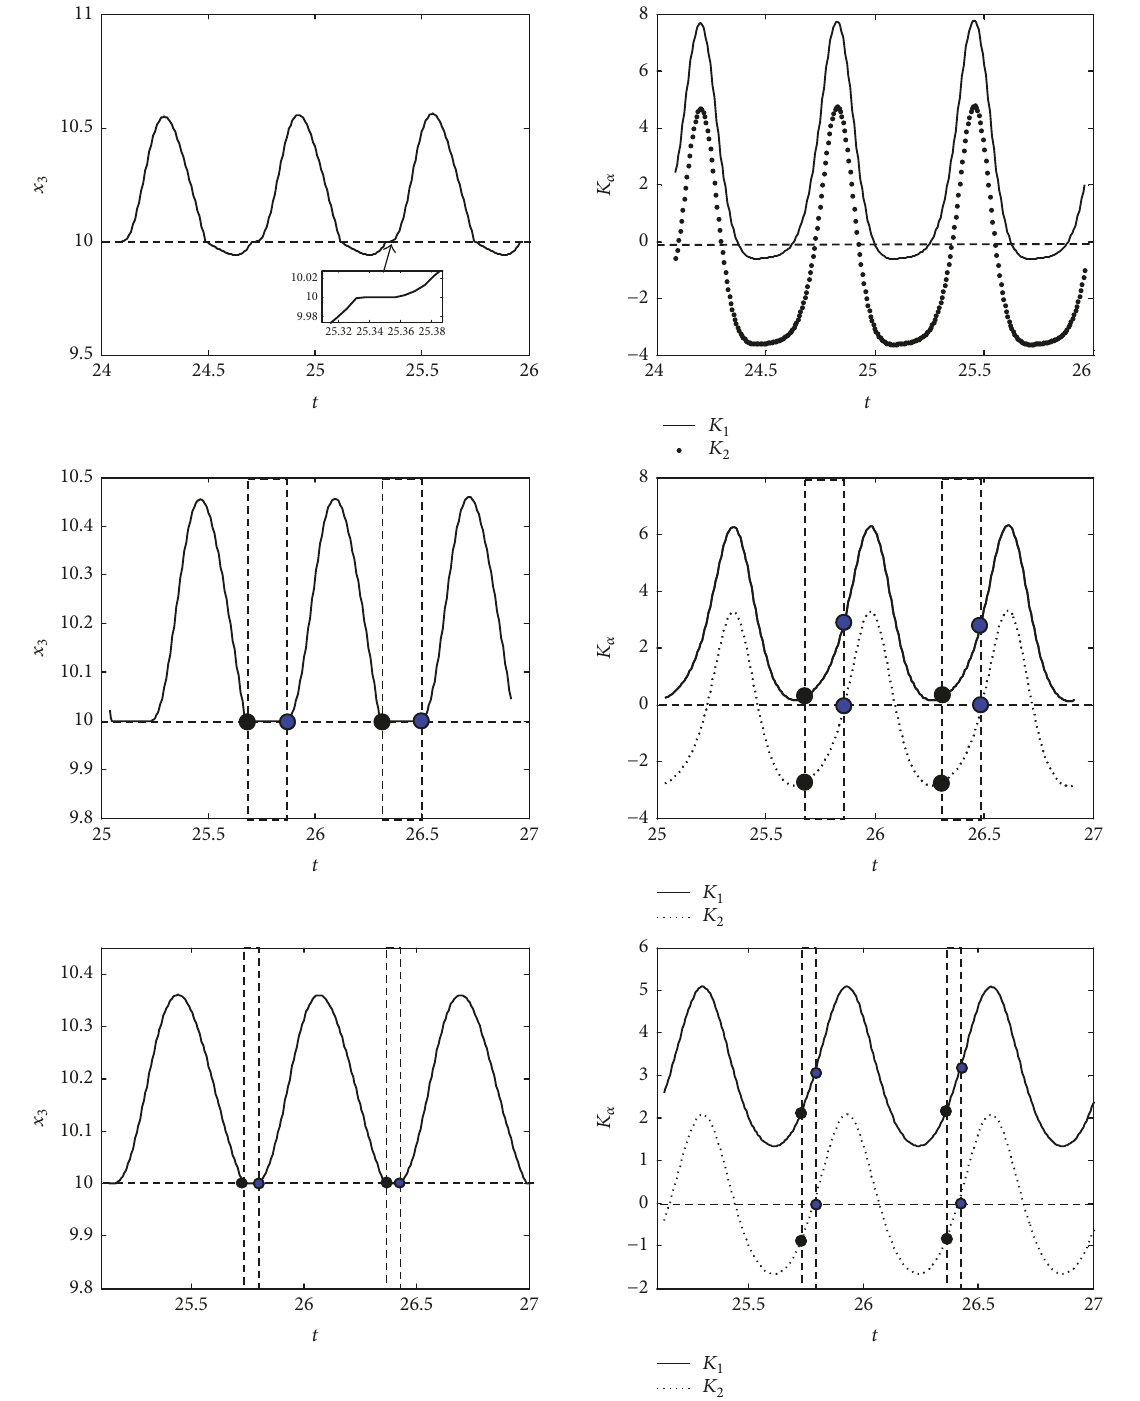
Figure 11: Time history and K